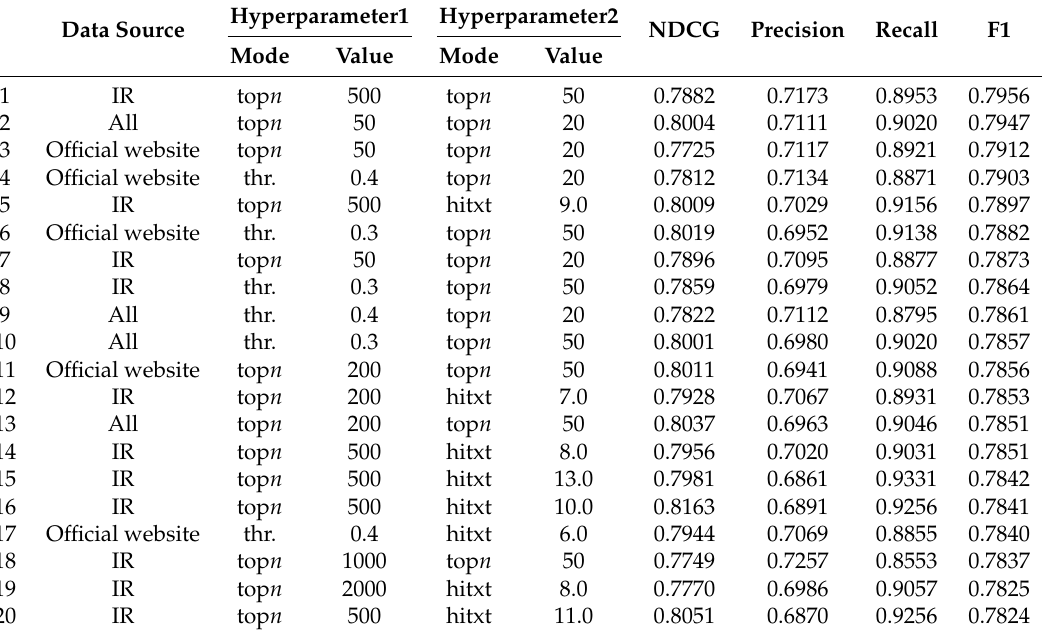
Table 7. Hyperparameter-tuning results based on F1.